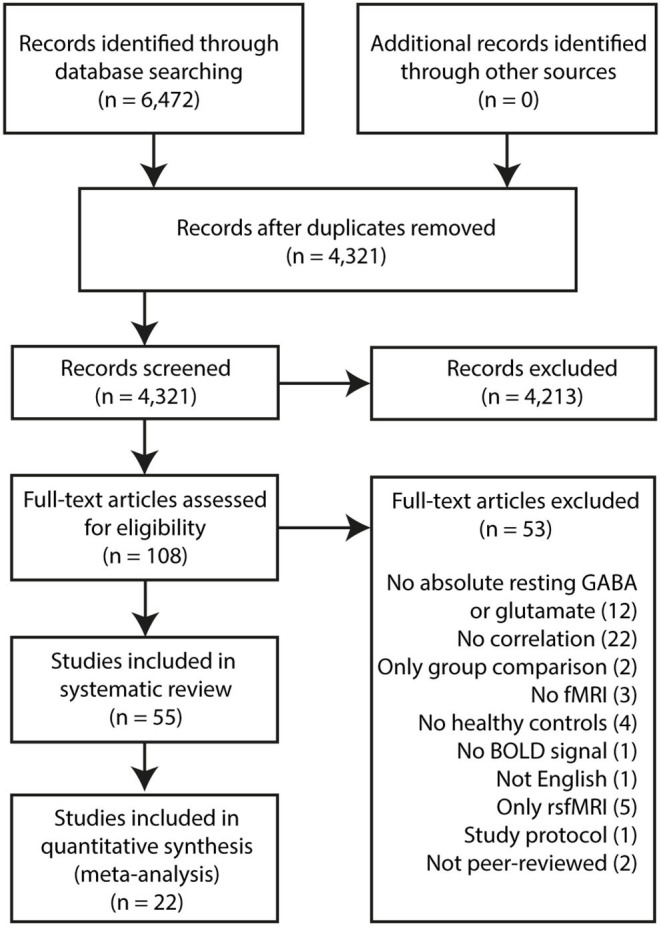
PRISMA Flowchart.